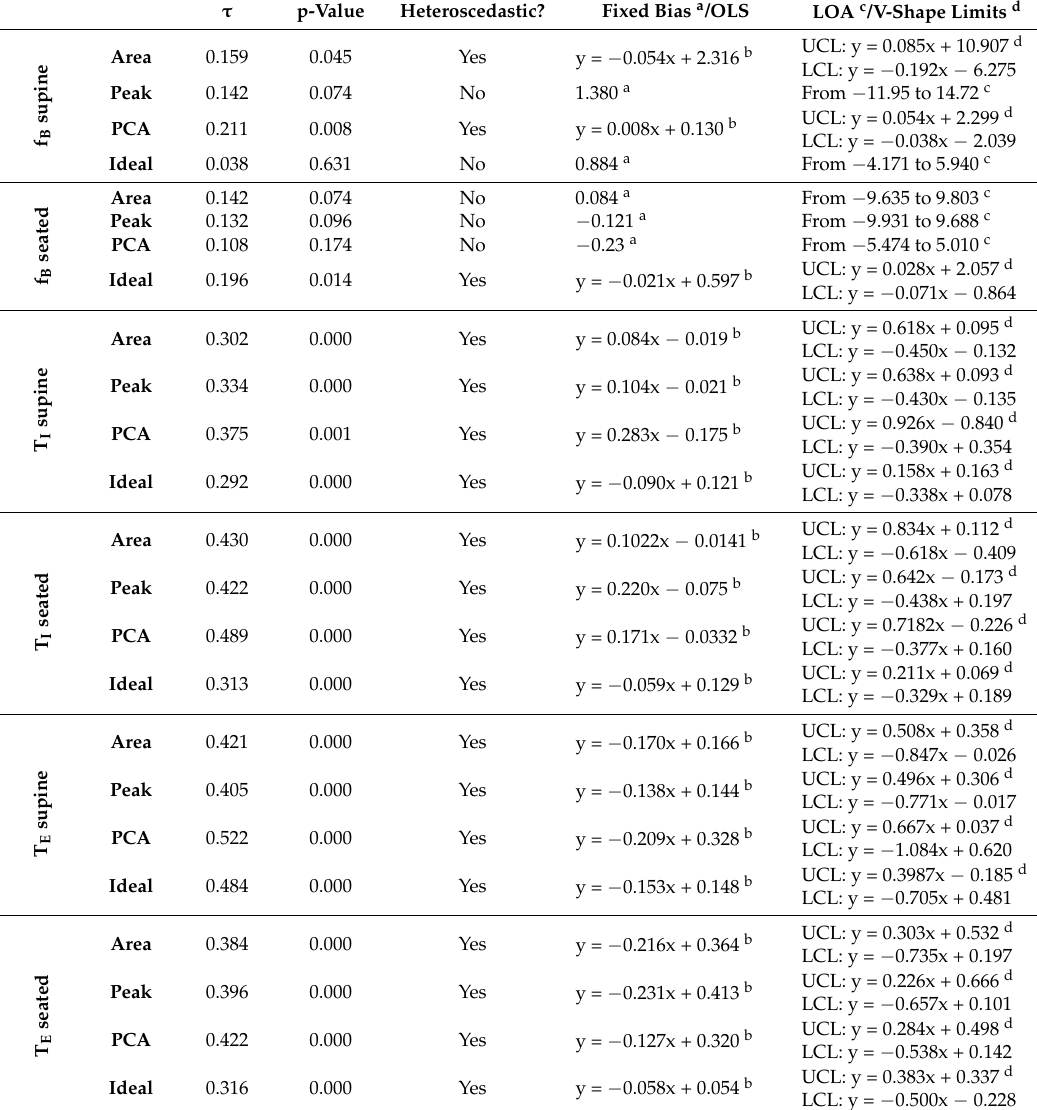
Table 4. Agreement analysis outcomes across subjects and different breathing patterns. Bland and Altman plot statistics for measurements of f B . T I . and T E using best component-selection methods (“Area” and “Peak”), PCA-fusion method and “Ideal” component and, in supine (n = 74) and seated (n = 74)